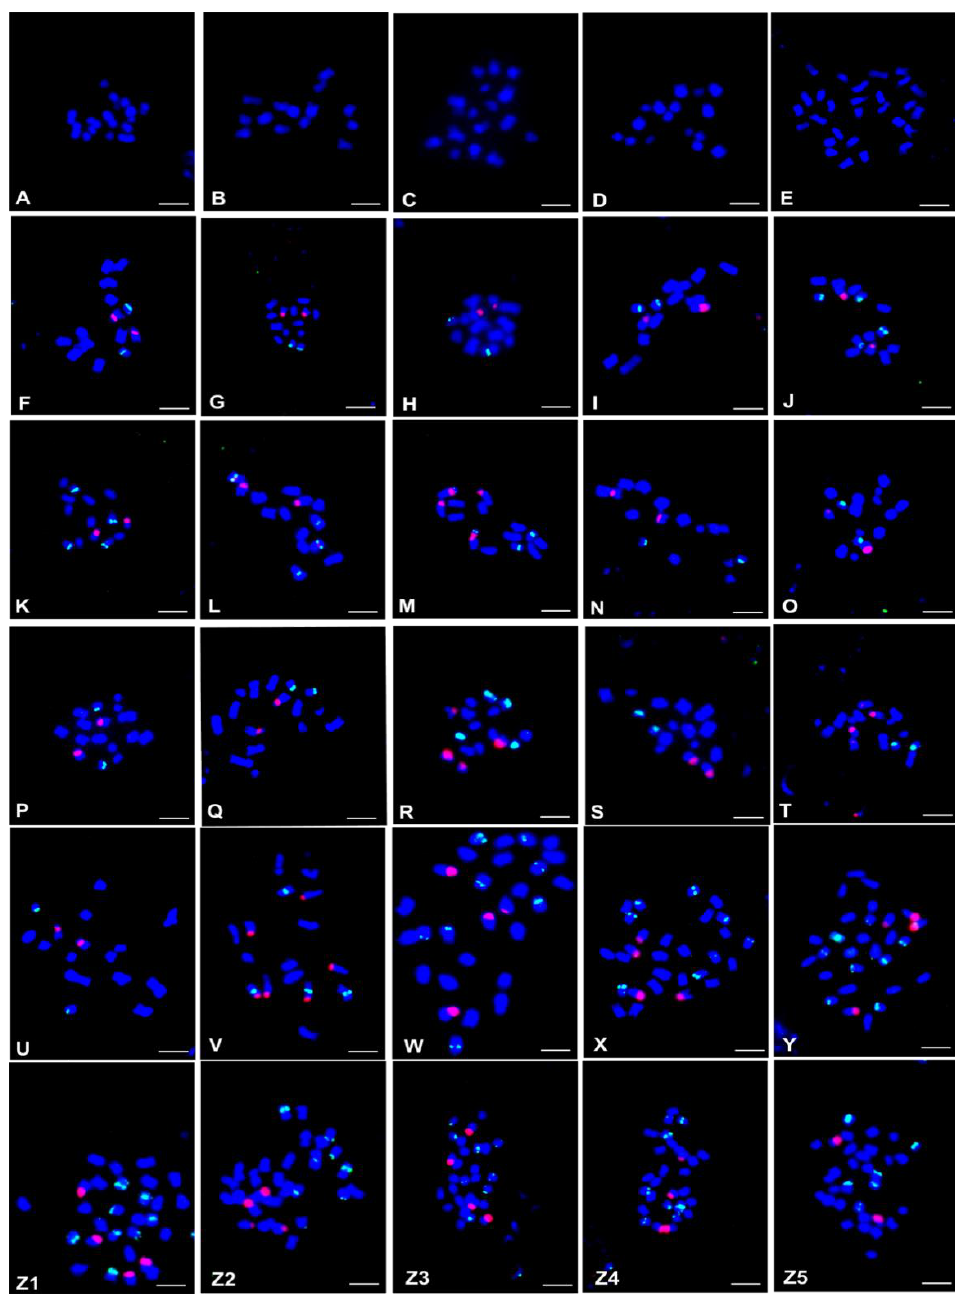
Figure 1. Chromosome number and distribution of rDNA loci in diploid and polyploid Onobrychis species. Fluorescence in situ hybridisation was performed with 5S rDNA probe (green fluorescence) and 35S rDNA probe (red fluorescence). ( A ) O. sternohiza , ( B ) O. humilis , ( C ) O. michauxii , ( D ) O. gaubae , ( E ) O. altissima , ( F ) O. grandis , ( G ) O. caput-galli , ( H ) O. ptolemaica , ( I ) O. hypargyrea , ( J ) O. gracilis , ( K ) O. supina , ( L ) O. megataphros , ( M ) O. alba subsp. laconica , ( N ) O. sintenisii , ( O ) O. vassilczenkoi , ( P ) O. chorossanica , ( Q ) O. kachetica , ( R ) O. persica , ( S ) O. radiata , ( T ) O. vaginalis , ( U ) O. iberica , ( V ) O. crista- galli , ( W ) O. viciifolia 1 (PI170583), ( X ) O. viciifolia (PI200872), ( Y ) O. arenaria , ( Z1 ) O. transcaucasica , ( Z2 O. cyri , ( Z3 ) O. biebersteinii , ( Z4 ) O . inermis , ( Z5 ) O. subacaulis. All bars: 5 µ